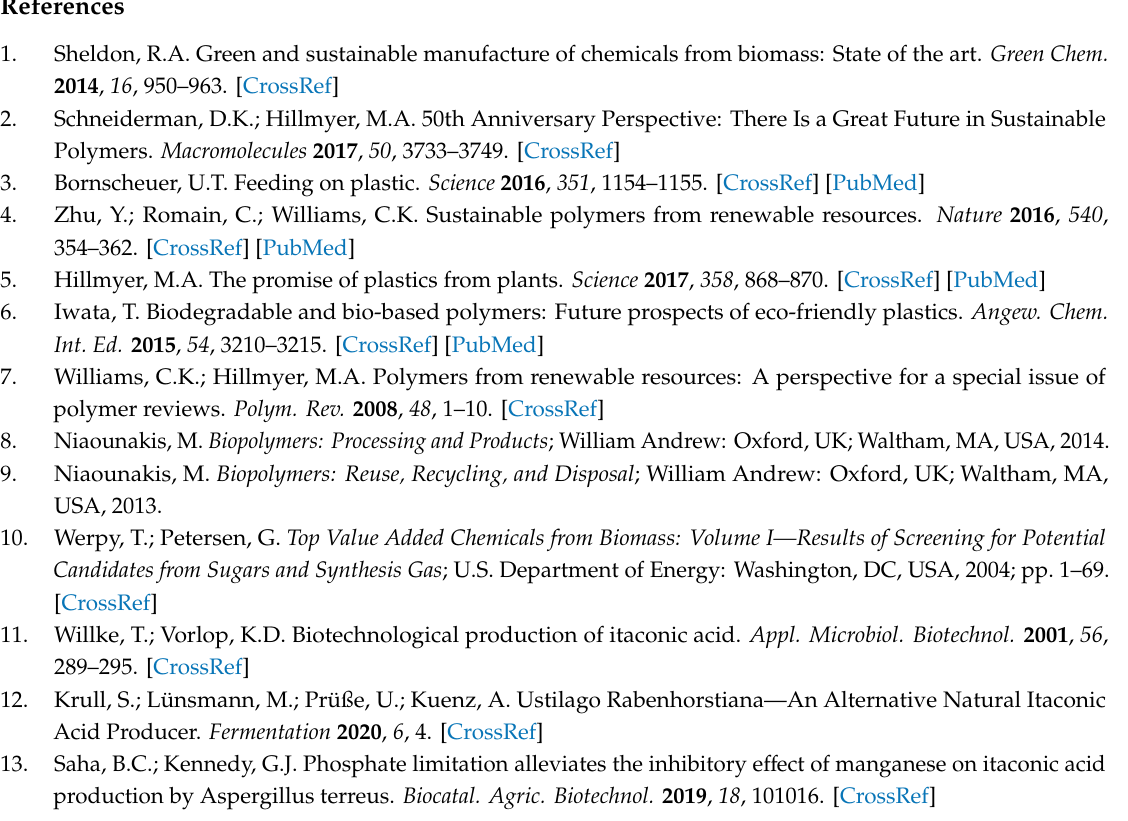
Figure S1: 1 H NMR spectra of the resins containing amido diol 6.6., Figure S2: Close up from 1 H NMR spectra. Top row AD 4.6, bottom row AD